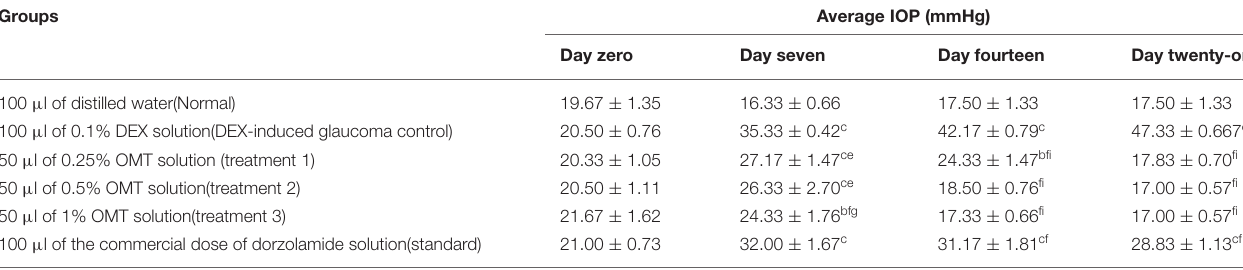
TABLE 1 | Effect of OMT on the IOP.